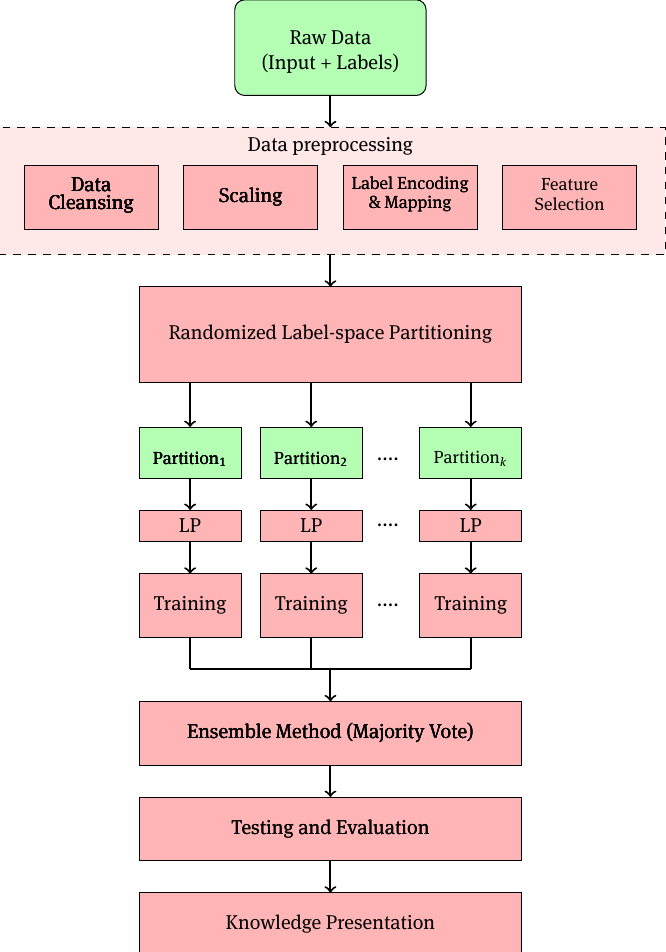
Figure 1: Scheme of the proposed